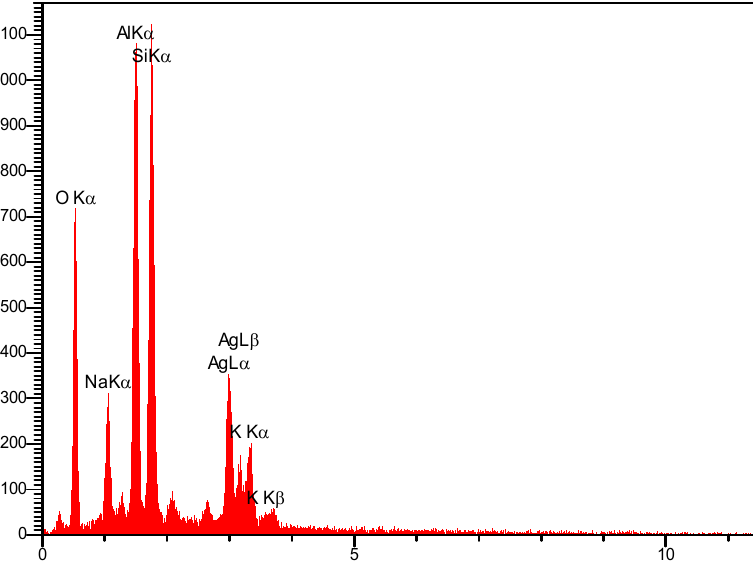
Fig. 7. EDS spectrum of the Ag NPs/Zeolite 13X Fig.7 EDS spectrum of the Ag NPs/Zeolite 13X nanocomposite.